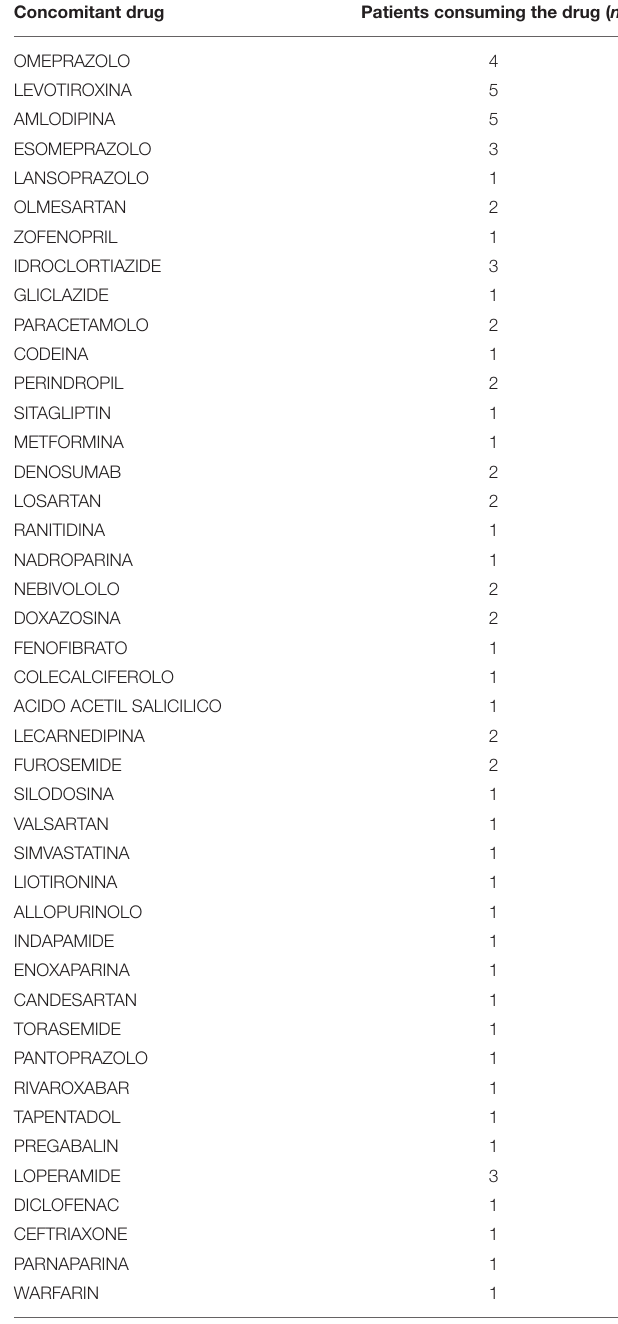
TABLE 2 | Variations of laboratory parameters before and after isoquercetin in patients on sunitinib – * ; ◦ Wilcoxon test for paired samples. Laboratory test— Unit of measure